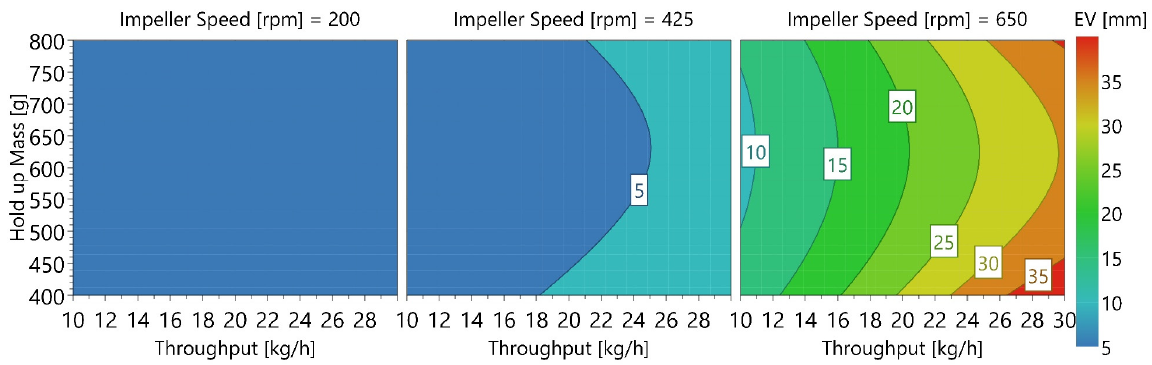
Figure 10. Contour plot of exit valve opening width in dependence of THR, HUM and IMP.